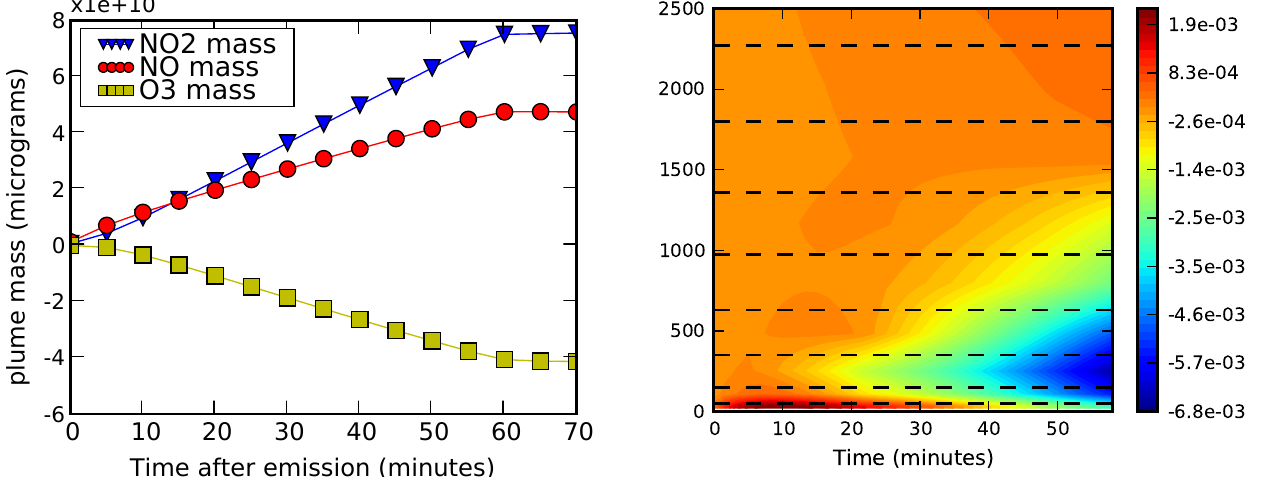
Fig. 1. Plume mass in µg for NO 2 , NO and O 3 with plume-in-grid. Simulation with one point source of NO x in a uniform background of O 3 .